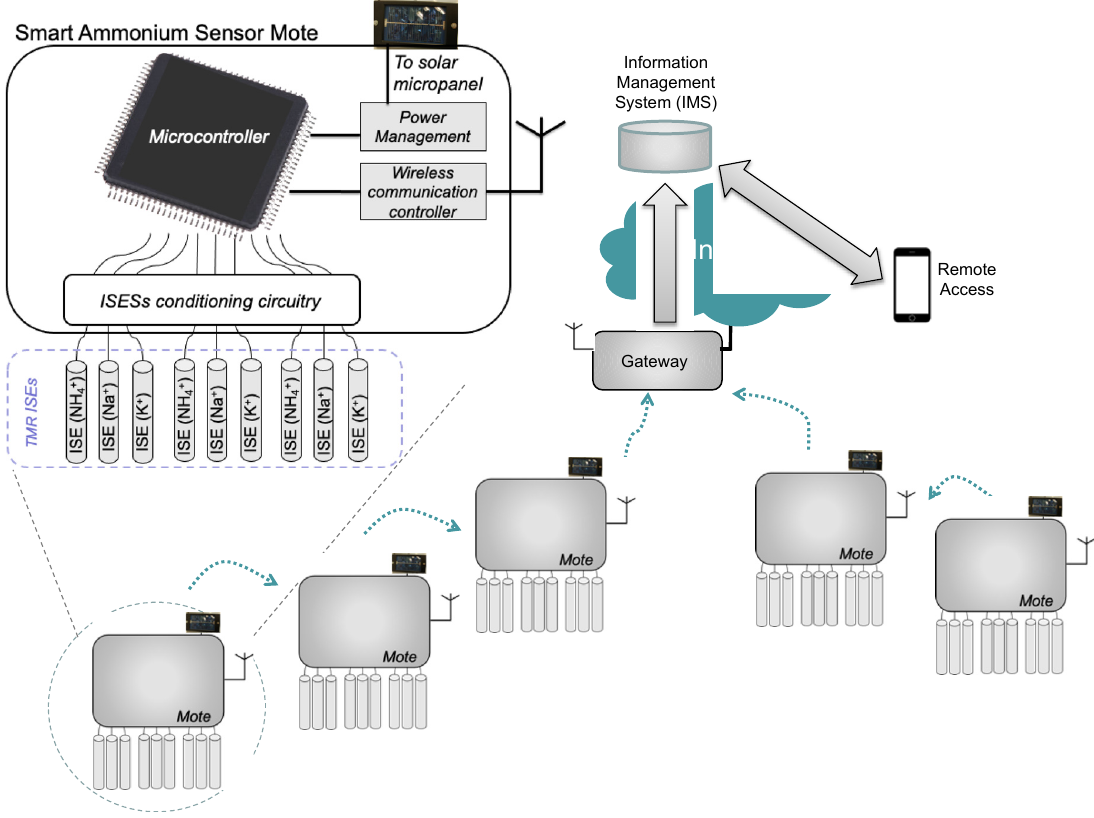
Figure 1. Proposed system architecture.